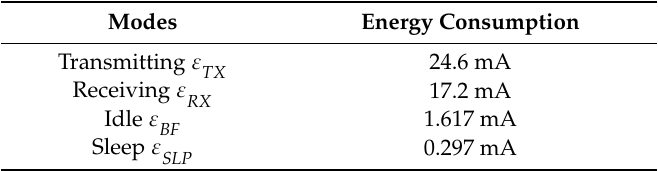
Table 2. Power consumption of Mica2 in di ff erent states